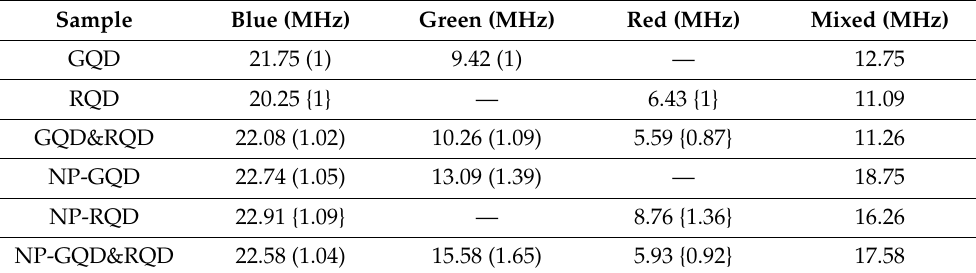
Table 1. MBs of blue, green, red, and mixed lights in all the samples under study when the injected current is 100 mA. The numbers within parentheses and curly brackets show the ratios of MBs with respect to individual normalization base in each